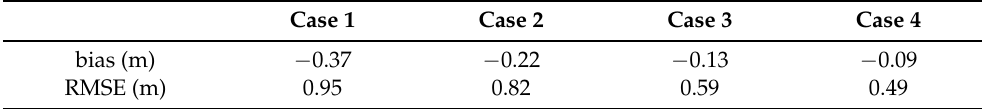
Table 1. The performance of each input parameter combination.